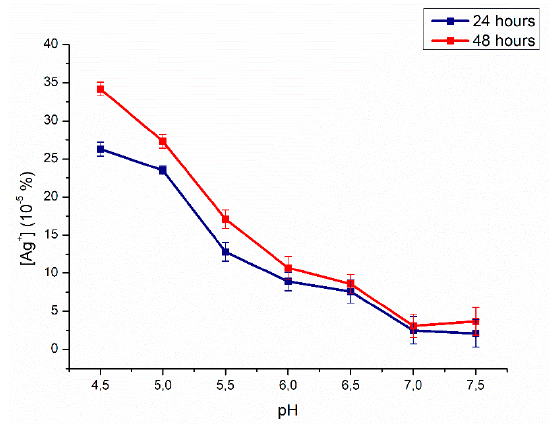
Figure 4. E ff ects of pH on Ag + release from PMMA–AgNPs C2 (3.5 wt%). NP degradation was Figure 4. Effects of pH on Ag + release from PMMA–AgNPs C2 (3.5 wt%). NP degradation was evaluated at pH 4.5, 5, 5.5, 6, 6.5, 7.5, and 7 up to 48 evaluated at pH 4.5, 5, 5.5, 6, 6.5, 7.5, and 7 up to 48 h.